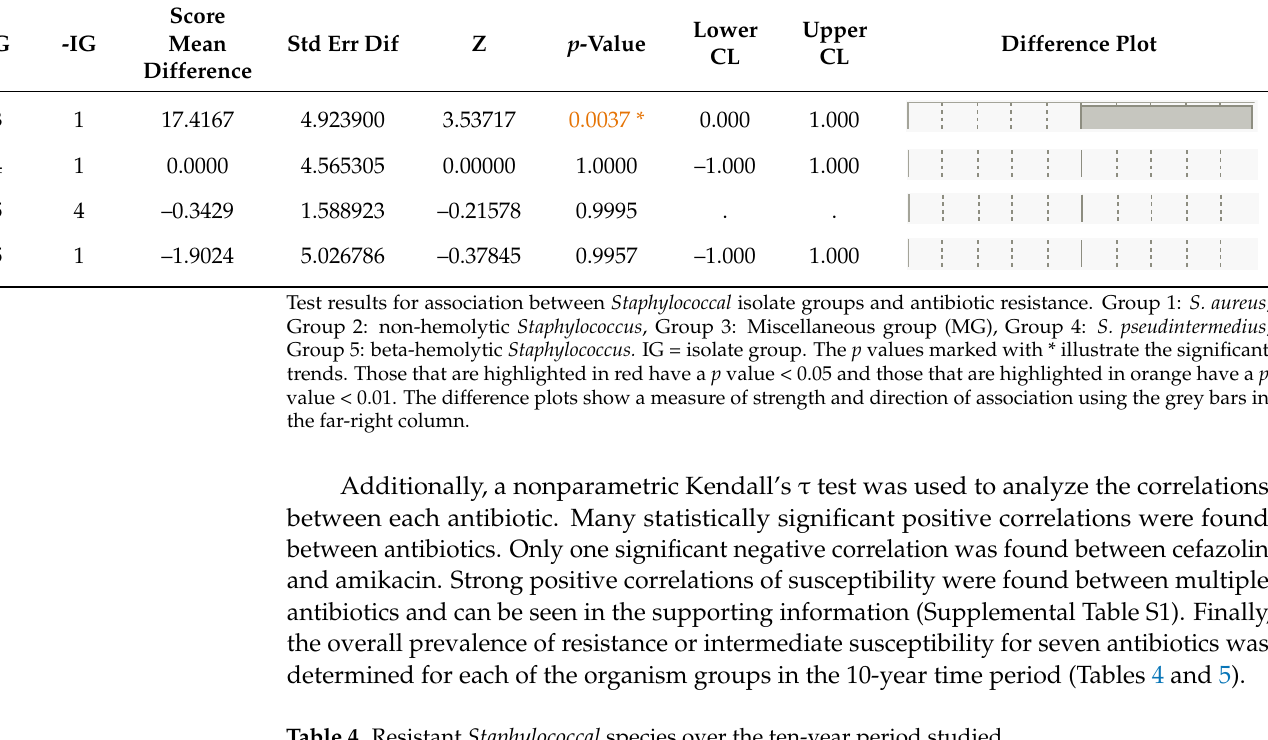
Table 4. Resistant Staphylococcal species over the ten-year period studied.